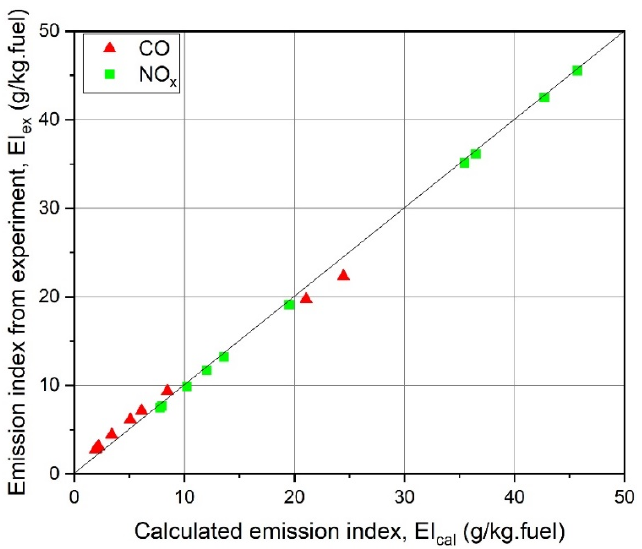
Figure 4. Comparison of calculated values of emission index with empirical values from experimental data ( ▲ : emission index of CO; ■ : emission index of NO x ).